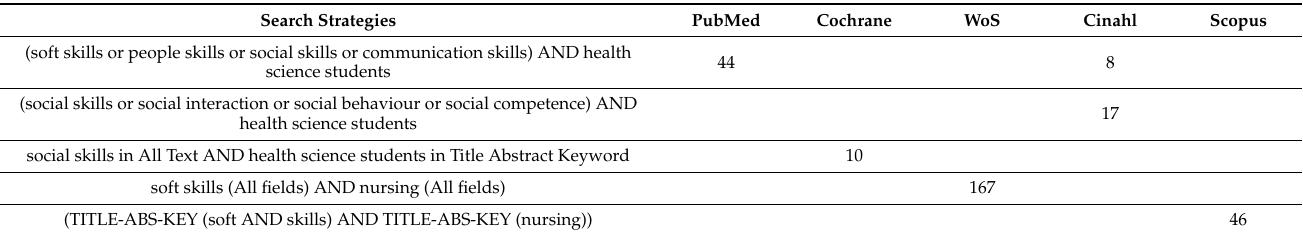
Table 1. Search strategies in the different databases. Search Strategies PubMed Cochrane